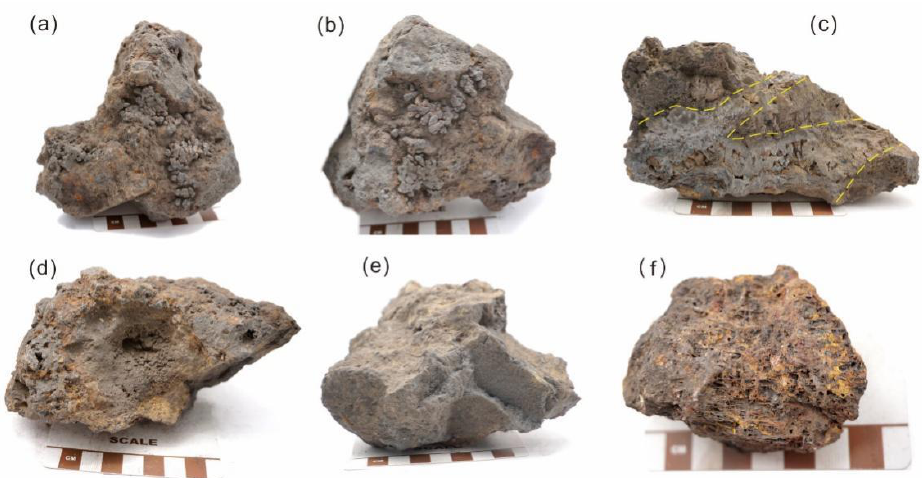
Figure 3. Representative hand specimens of the Mn-oxide ore in the Xialei deposit. ( a ) and ( b ) Oolitic and pisolitic texture; ( c ) oolitic-banded texture (yellow dashed line indicates the banded